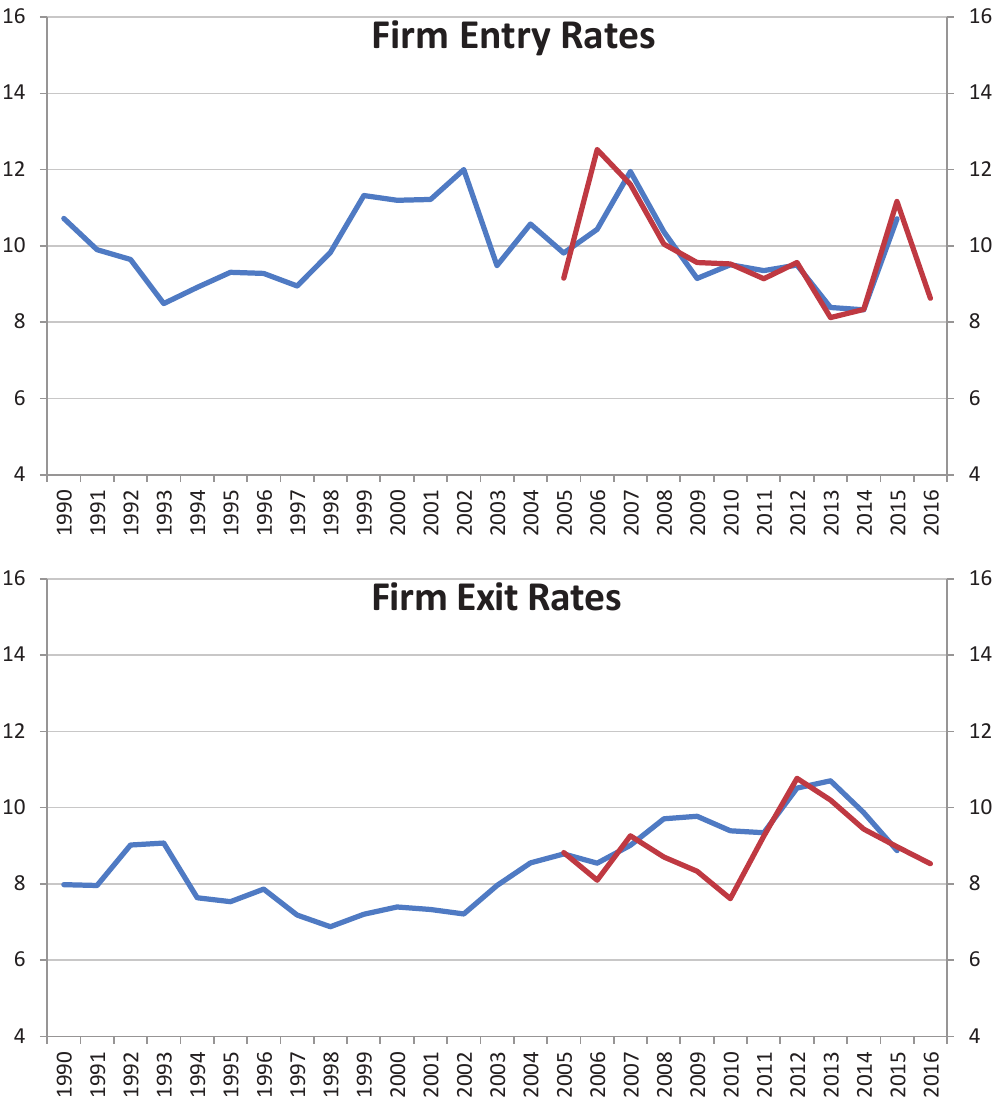
Figure A2 Representativeness of INPS and ESBS entry and exit